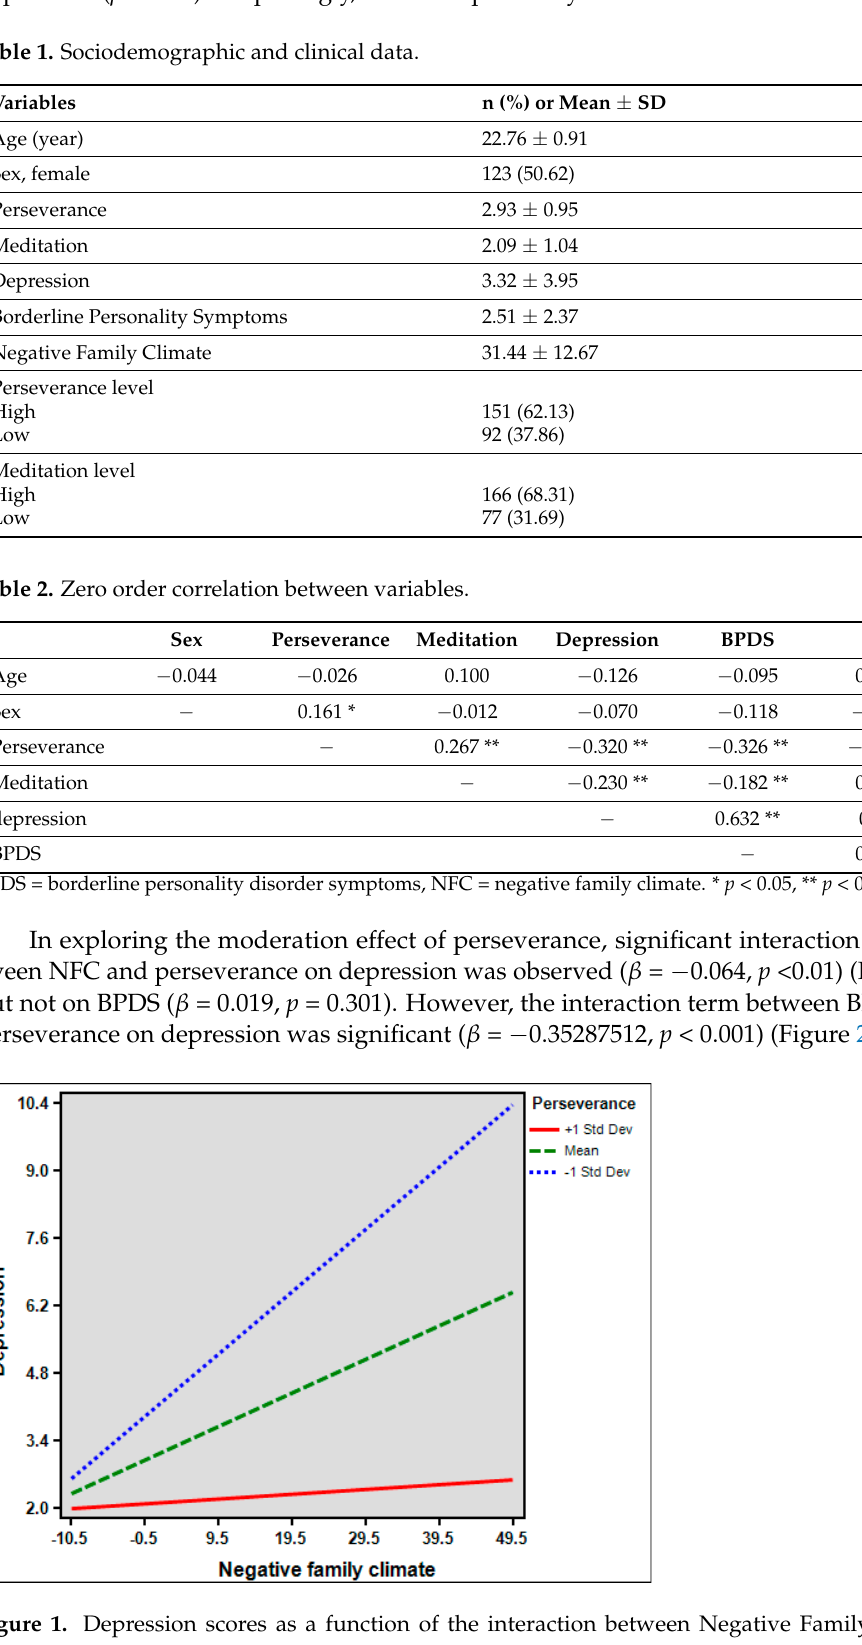
Figure 2. Depression scores as a function of the interaction between borderline personality disorder symptoms and perseverance. In exploring the moderation effect of meditation, significant interaction term between NFC and meditation on BPDS was observed ( β = − 0.035, p < 0.001) (Figure 3), likewise on depression ( β = 0.073, p < 0.001) (Figure 4). However, the interaction term between BPDS and meditation on depression was significant ( β = − 0.012, p = 0.881).